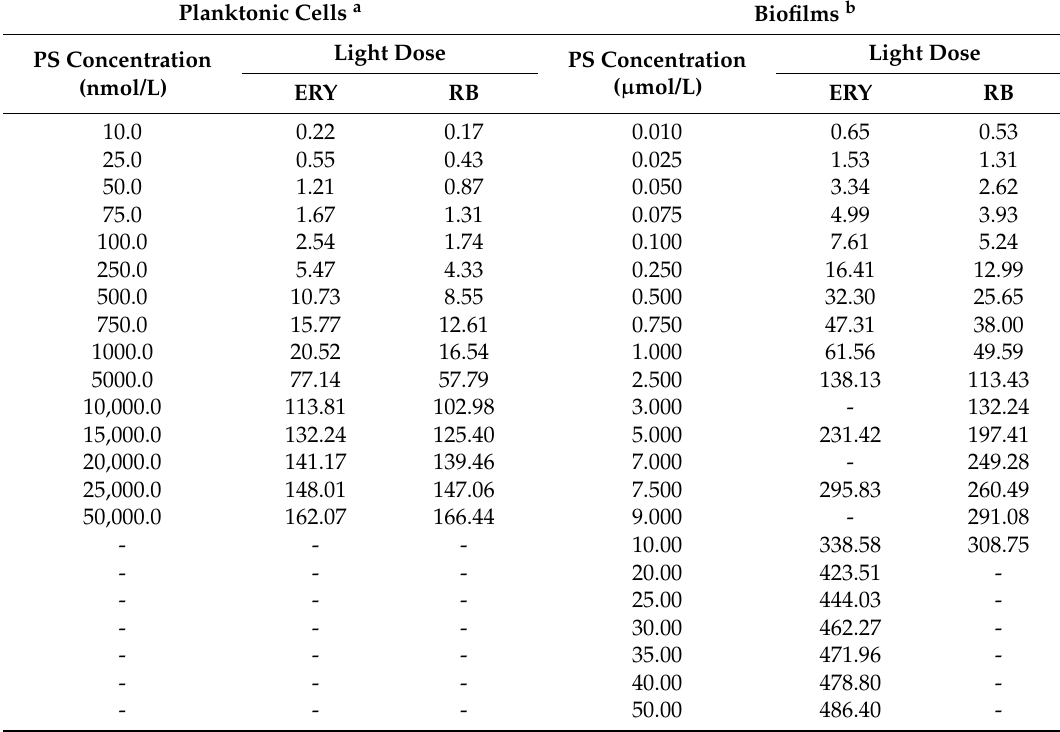
Table 1. Light dose values (J/cm 2 ) obtained with different PS concentrations and light exposure times. Planktonic Cells